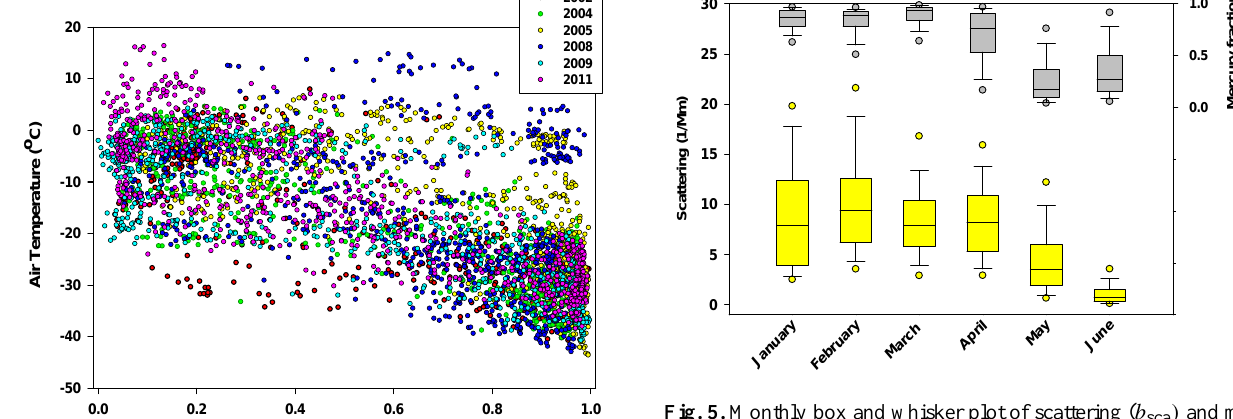
Fig. 5. Monthly box and whisker plot of scattering ( b sca ) and mer- cury fraction data from Alert. Nephelometer data is in (Mm − 1 ) for 550nm (yellow) from January to June 2004 to 2009. Mercury frac- tion data is unitless and is from January to June 2002 to 2011. Cen- tre line in the box represents the median value, the boundaries of the box represent the 25th and 75th percentiles, the whiskers represent the 10th and 90th percentile and the dots represent the 5th and 95th